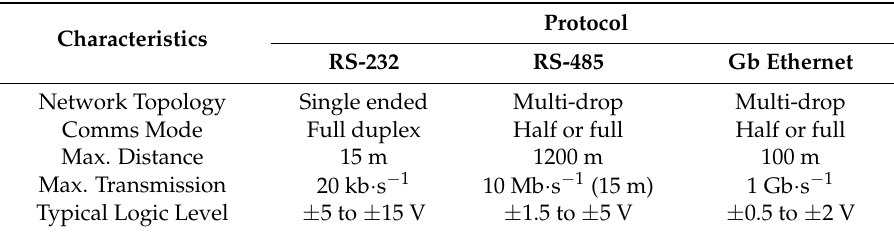
Table 6. Comparison of ROV communications